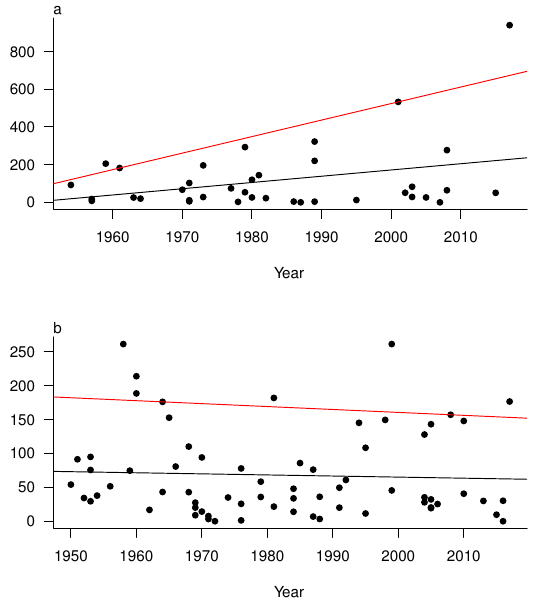
Figure 9. Time series plots with year on the x-axis and accumulated rainfall amounts on the y-axis. Black lines indicate the ordinary least squares regression model and red lines are the models at the 90th percentile. ( a ) Houston, Texas. ( b ) Miami,